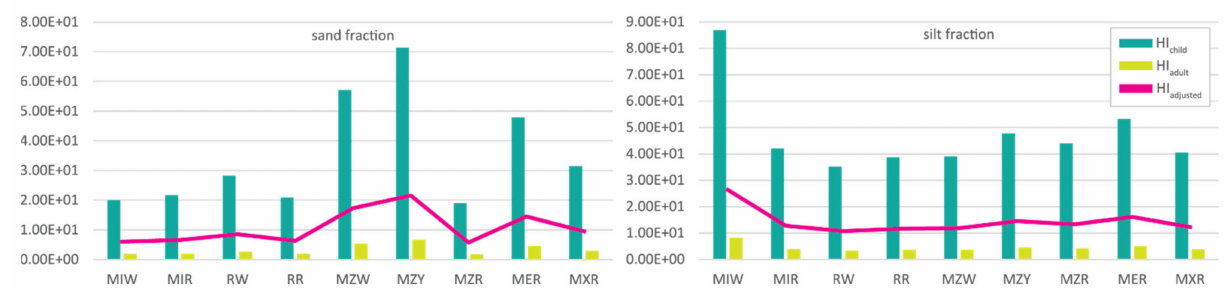
Figure 7. Geophagic material sand and silt fractions HI child , HI adult , and HI adjusted .